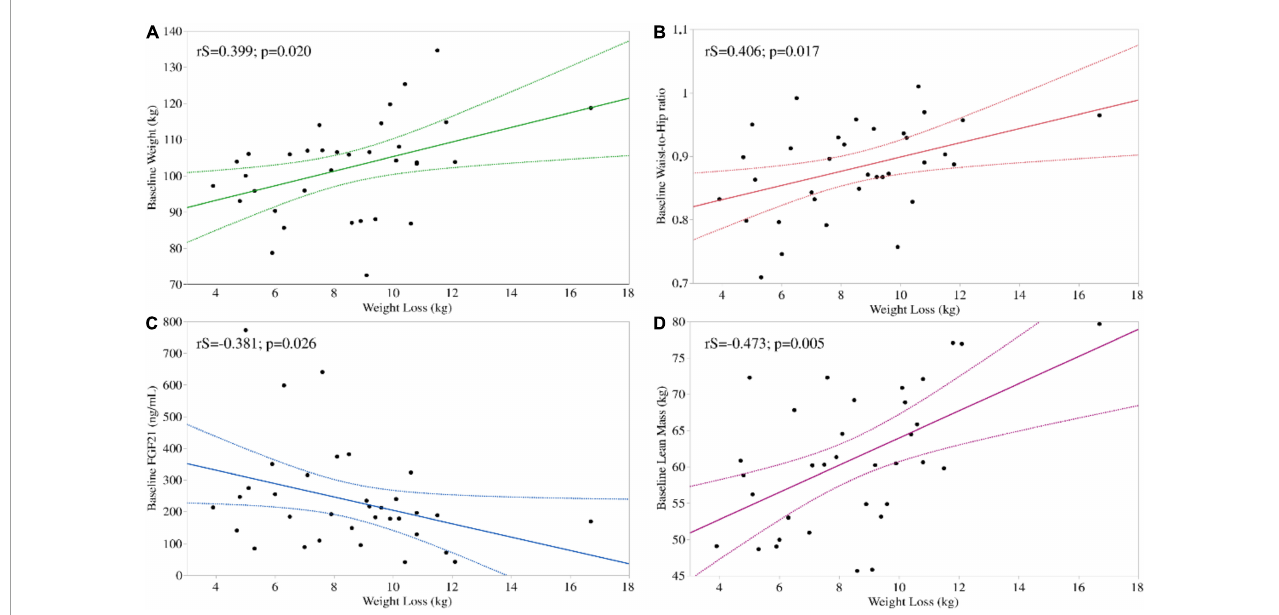
FIGURE1 Significant univariate associations between baseline parameters and weight loss following a VLCKD. Weight loss correlated positively with baseline body weight (A) and W/H ratio (B) and negatively with baseline circulating FGF21 (C) . Regarding body composition, weight loss positively correlated with baseline lean mass